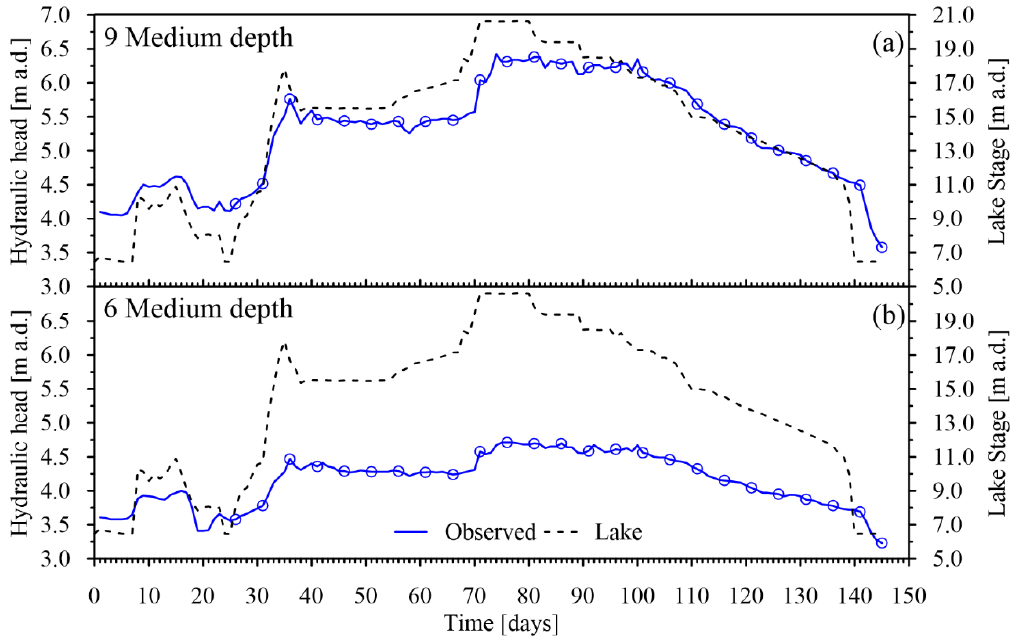
Figure 4. Lake stage above datum (a.d.) during the analyzed 145 days ( a and b ), observed hydraulic heads in two monitoring wells: no. 9 ( a ) and no. 6 ( b ), both at medium depth. The circles identify the hydraulic heads used in the inversion process. The location of the monitoring points is reported in Figure 1.